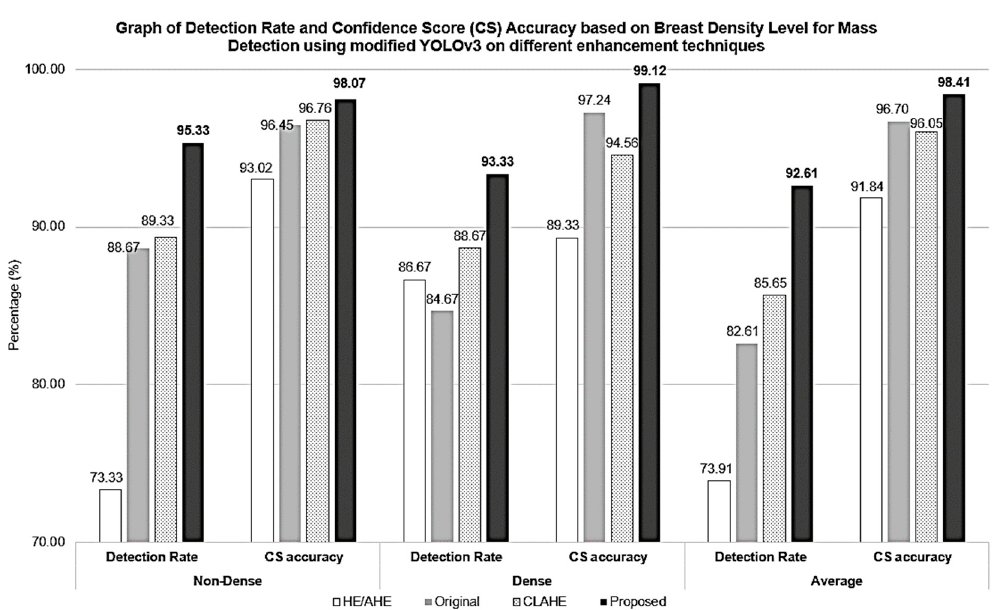
Figure 9. Graph of Detection Rate and Confidence Score (CS) Accuracy based on Breast Density Level for Mass Detection using modified YOLOv3 on different enhancement techniques.